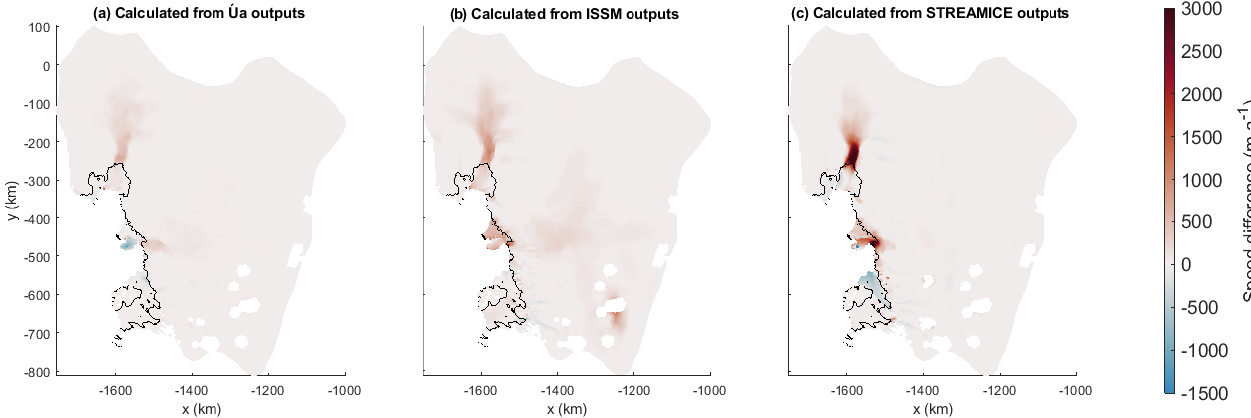
Figure C1. Differences between the speed calculated diagnostically in Úa using the B and β 2 outputs from each model and the original speed measurements used for the inversions. These calculations are performed on Mesh2, a coarser mesh than Úa’s inversion.